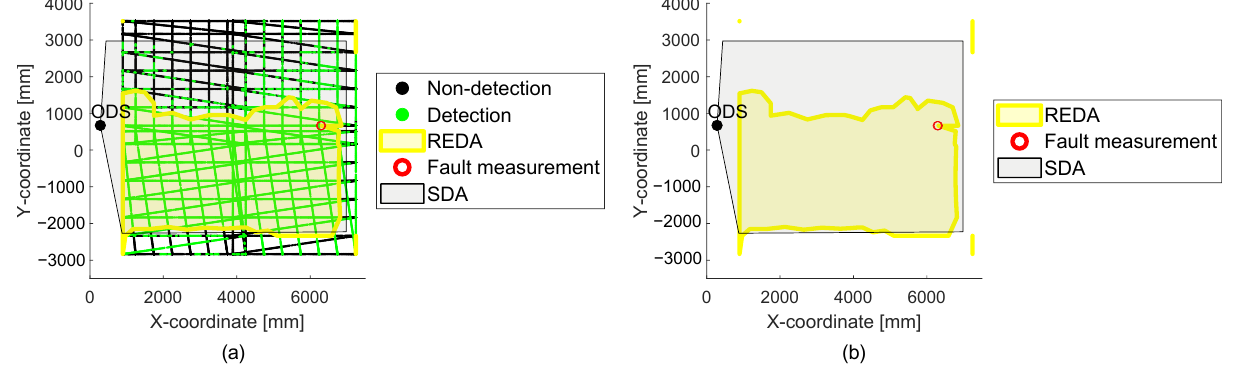
measurement without the whole point cloud is shown. Thus, a simpler and clearer manual visual observation and evaluation of the measurement is helpful. In part (a) of Figure 7, the same data from the previous figure is shown. In the visualization without the point cloud in part (b), a clearly different REDA area can be seen in comparison to the set SDA of the ODS.